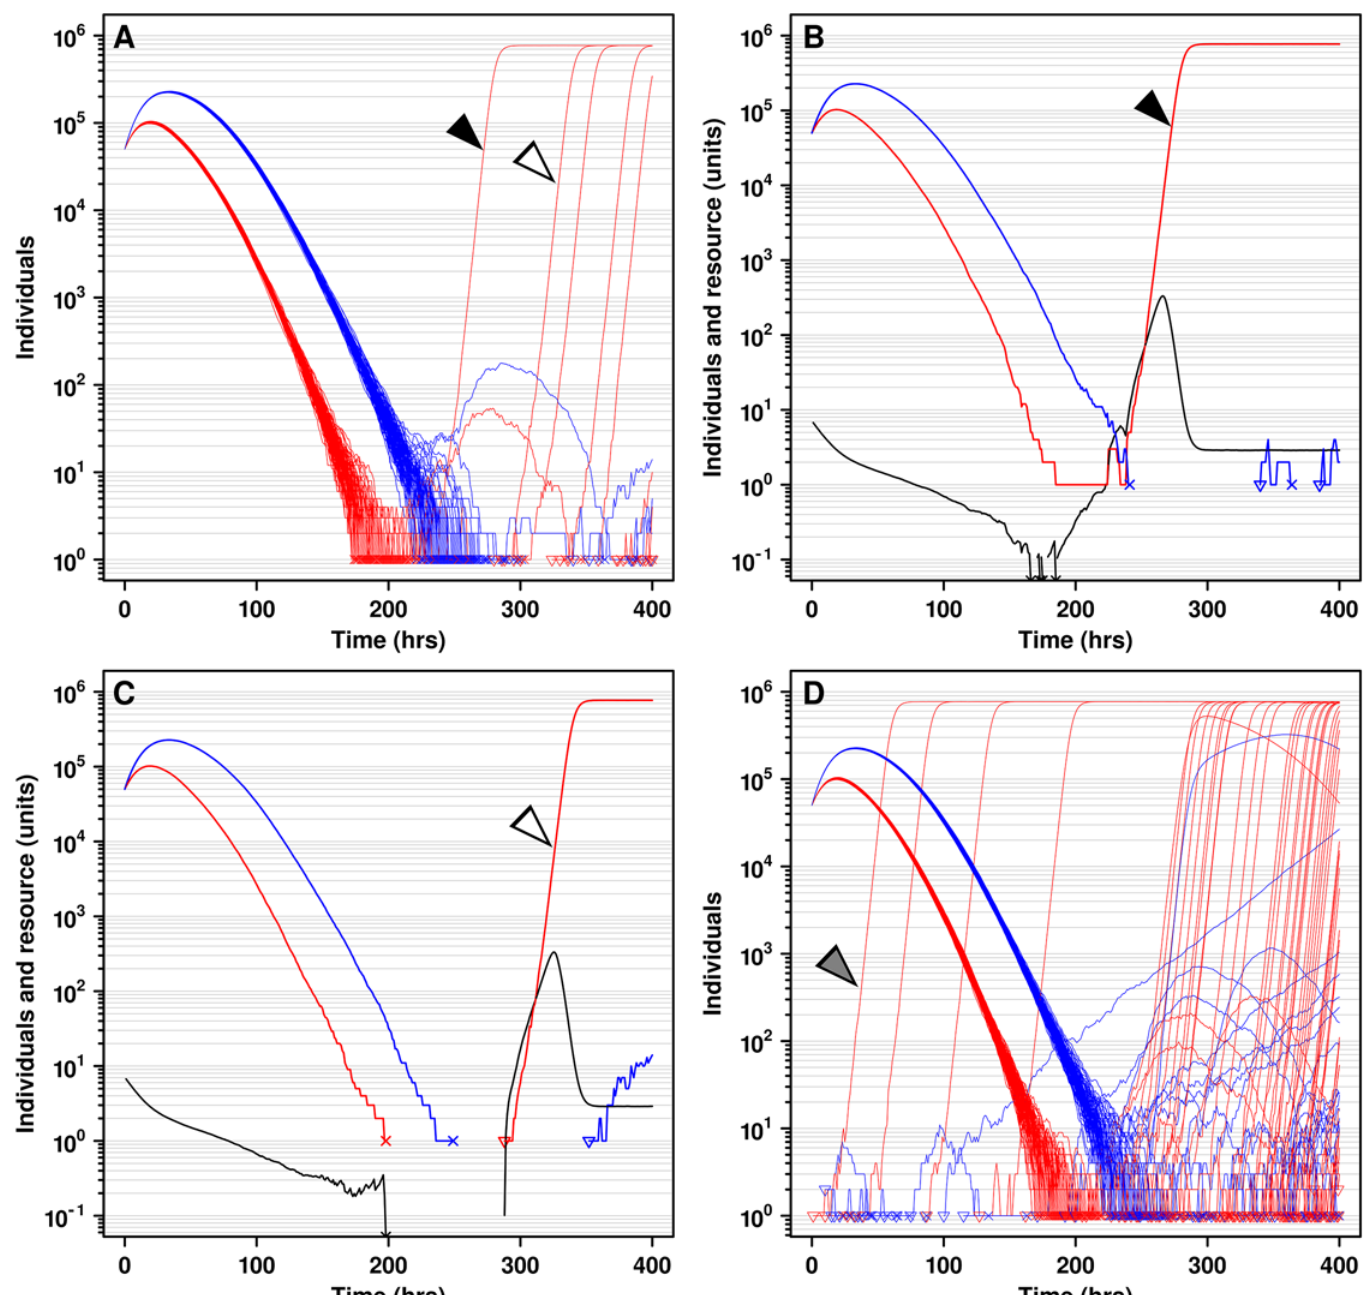
Fig 4. Multiple mechanisms allow cooperators to survive defector-induced population collapse. A and D each shows one example simulation of one metapopulation of C and D only, with 144 locations and a migration rate and a mutation rate u D of 10 − 7 hr -1 . Each red or blue curve depicts the trajectory of C or D , respectively, in one location within the metapopulation. Small open triangles at the beginning of a population trajectory indicate the appearance of a new subpopulation via immigration or mutation. While we do not visually distinguish between these two types of events, one can infer, for example, that the appearance of an individual in an initially empty location must have occurred due to migration. ( A - C ) In an initially fully-occupied metapopulation, all empty locations must have been created by defector-induced extinction. All 144 locations of a metapopulation were initialized with 10 5 individuals at a 1:1 C to D ratio. In an example metapopulation where cooperators achieved a high final frequency ( A ), D drove C extinct (X's at 1 on the ordinate) before suffering self- extinction in 143 out of 144 locations. However, in one location (black arrowhead, details in B ), D went extinct before C , allowing the increase of C and the spread of C by migration to locations where D had driven C extinct (example shown by white arrowhead, details in C ). In B and C , resource levels (black) were plotted. Downward-facing arrowhead on resource indicates that the resource concentration went below the plotted scale. ( D ) In a metapopulation with 90% locations initially occupied, C individuals were also able to migrate into and grow in initially empty locations (gray arrowhead).